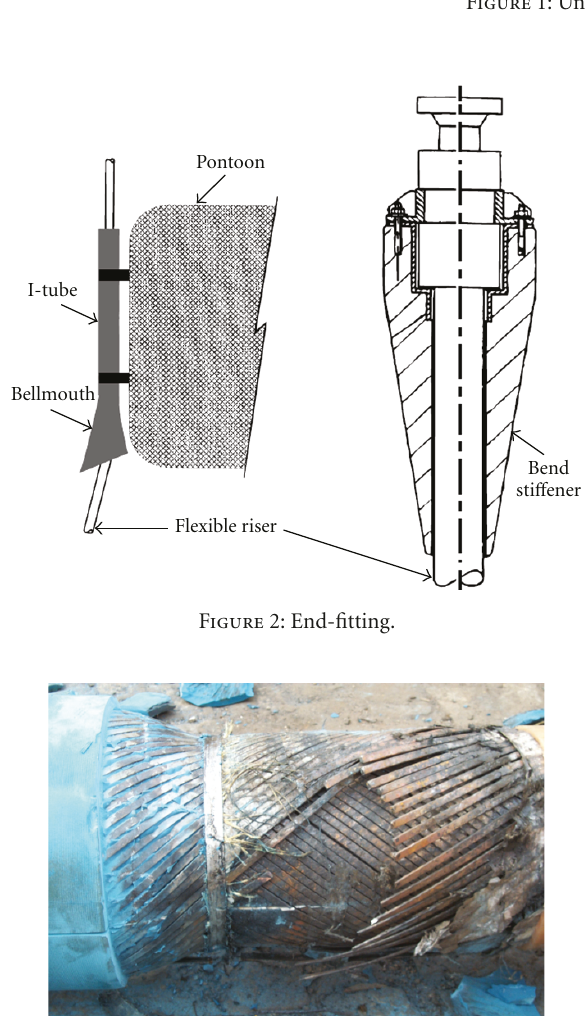
Figure 1: Unbonded flexible pipe.